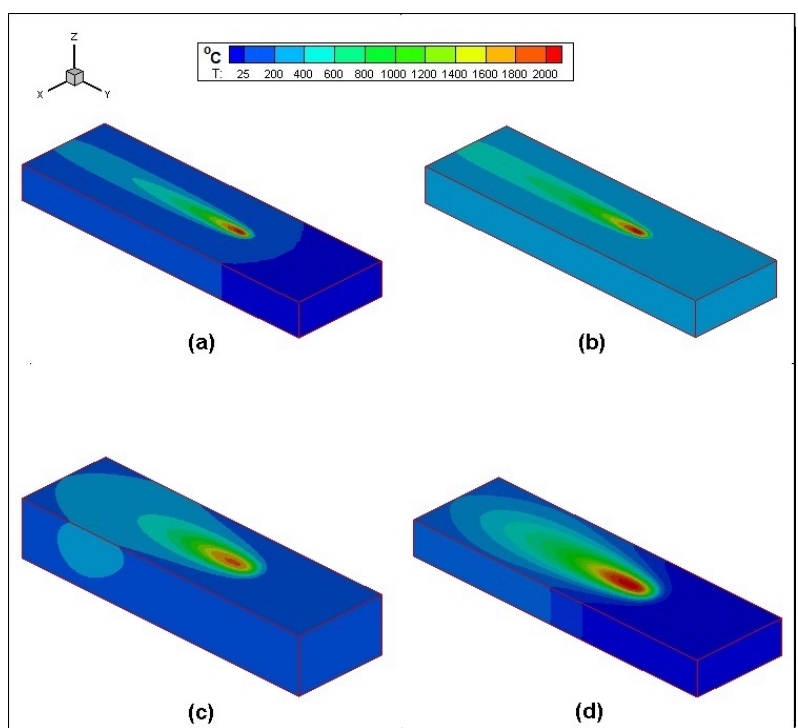
Figure 6 - Three dimensional transient temperature distribution during welding: (a) 0.5 kJ mm -1 and 10 mm thick (after 11.7 s); (b) 0.5 kJ mm -1 and 10 mm thick plus preheating (after 11.7 s); (c) 3 kJ mm-1 and 25 mm thick (after 70 s) and (d) 3 kJ mm -1 and 10 mm thick (after 70